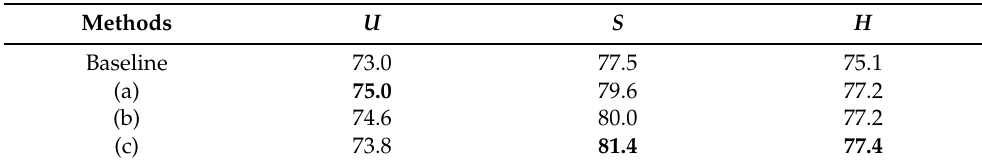
Figure 3. Zero-shot image retrieval result comparison between CVAE, SDGZSL, and ESTD-GZSL. Table 3. Ablation study for different components of ESTD-GZSL on the CUB dataset. The best results are marked in boldface .